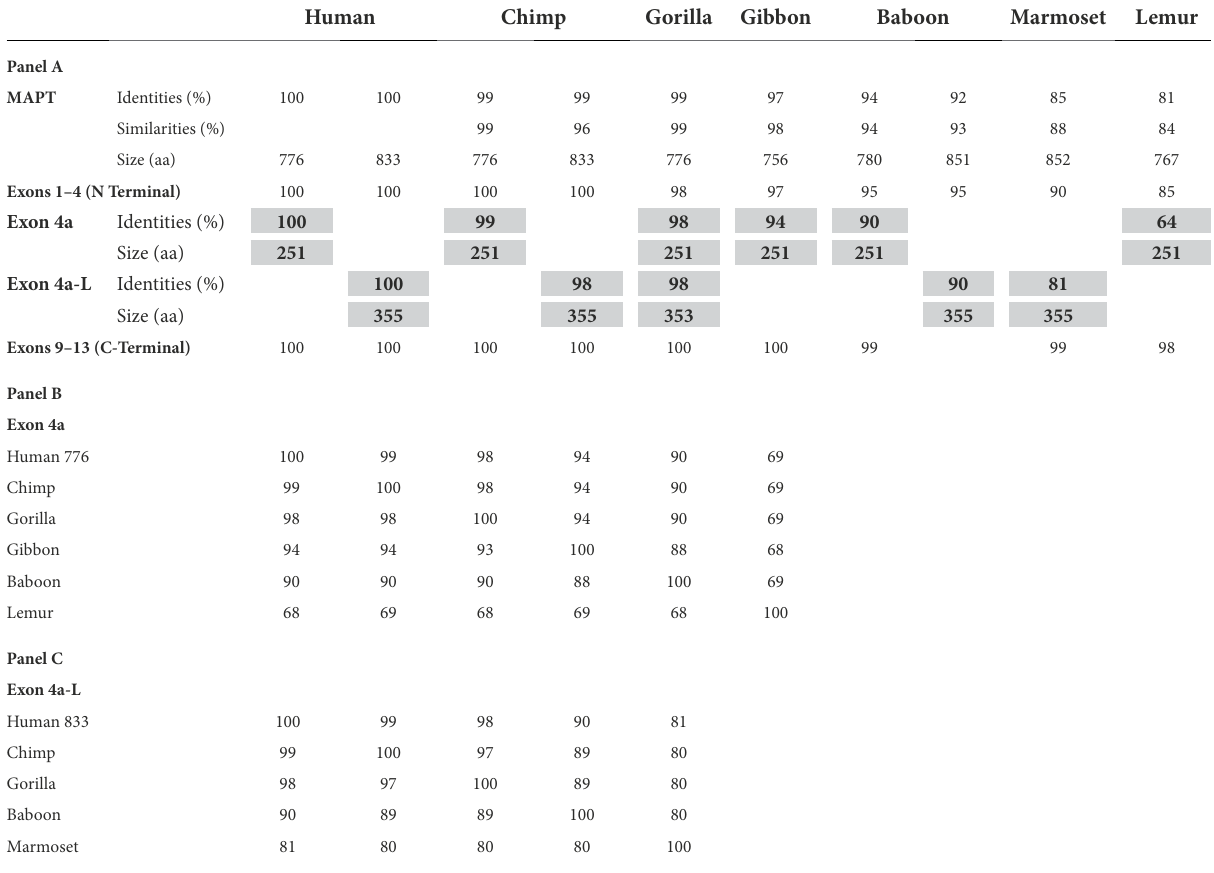
Panel A: MAPT sequence homology was analyzed against human (776aa and 833aa) for chimpanzees (776aa and 833aa), gorilla (776aa), Gibbon (756aa), baboon (780aa and 851aa), marmoset (852aa), and lemur (767aa) all taken from the database presented in Supplementary Figure 1. It included homology (identity and similarity) for the complete MAPT sequence relative to human MAPT, exons 1–4 representing the N-terminal, exon 4a, exon 4a-L and exons 9–13 representing the C-terminal including the MTBD. Panel B: matrix identity for exon 4a. Panel C: matrix identity for exon